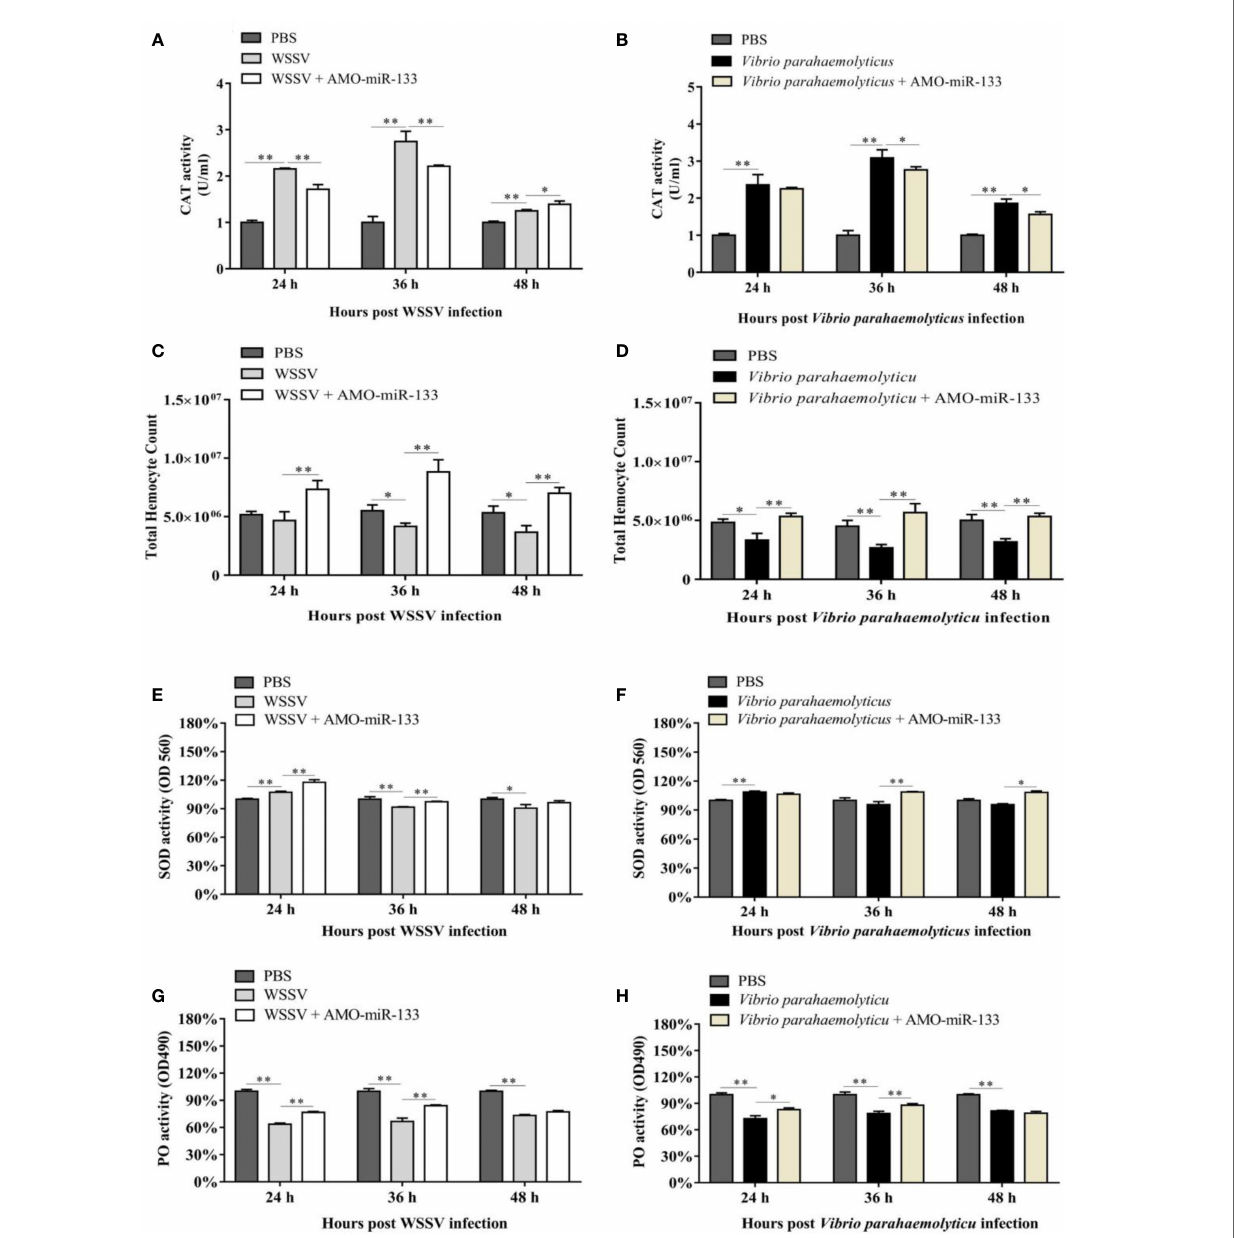
FIGURE 4 | Samples were taken at different times (24, 36, and 48 h) post-treatment. (A) CAT activity in the WSSV (24 h P = 0.0000023, 36 h P = 0.000046 and 48 h P = 0.00035) or WSSV + AMO-miR-133 group (24 h P = 0.0017, 36 h P = 0.00062 and 48 h P = 0.033). (B) CAT activity in the V. parahaemolyticus (24 h P = 0.0012, 36 h P = 0.000065 and 48 h P = 0.00025) or V. parahaemolyticus + AMO-miR-133 group (24 h P = 0.55, 36 h P = 0.031 and 48 h P = 0.020). (C) Effect of AMO-miR-133 on THC of WSSV-challenged mud crabs. WSSV group (24 h P = 0.35, 36 h P = 0.016 and 48 h P = 0.024). WSSV + AMO-miR-133 group (24 h P = 0.0031, 36 h P = 0.0017 and 48 h P = 0.001641289). (D) The effect of AMO-miR-133 on THC of V. parahaemolyticus- challenged mud crabs. V. parahaemolyticus group (24 h P = 0.016, 36 h P = 0.0053 and 48 h P = 0.0053). V. parahaemolyticus + AMO-miR-133 group (24 h P = 0.0058, 36 h P = 0.0031 and 48 h P = 0.00078). (E) SOD activity in the WSSV (24 h P = 0.0013, 36 h P = 0.0046 and 48 h P = 0.021) or WSSV + AMO-miR-133 group (24 h P = 0.0043, 36 h P = 0.000052 and 48 h P = 0.079). (F) SOD activity in the V. parahaemolyticus (24 h P = 0.00086, 36 h P = 0.14 and 48 h P = 0.055) or V. parahaemolyticus + AMO- miR-133 groups (24 h P = 0.078, 36 h P = 0.0022 and 48 h P = 0.018). (G) PO activity after WSSV or WSSV + AMO-miR-133 challenge. WSSV group (24 h P = 0.0000096, 36 h P = 0.00029 and 48 h P = 0.0023). WSSV + AMO-miR-133 group (24 h P = 0.00031, 36 h P = 0.0023 and 48 h P = 0.15). (H) PO activity after V. parahaemolyticus or V. parahaemolyticus + AMO-miR-133 treatment. V. parahaemolyticus group (24 h P = 0.00029, 36 h P = 0.00067 and 48 h P = 0.000021). V. parahaemolyticus + AMO-miR-133 group (24 h P = 0.010, 36 h P = 0.0080 and 48 h P = 0.069). The results are shown as mean ± standard deviation of three independent experiments. Signi fi cant difference between different samples is indicated by * P < 0.05 and ** P <